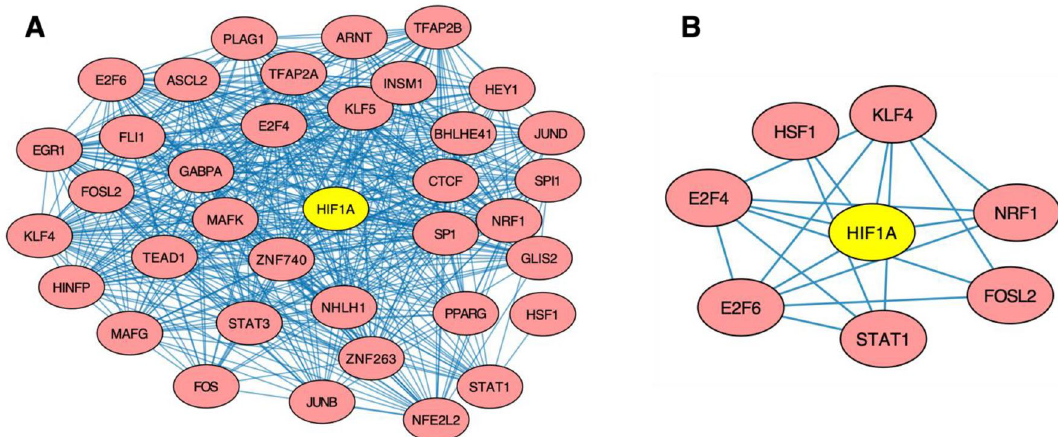
Figure 4. Interactions between discovered HIF1A cofactors. ( A ) Cytoscape representation of the top 37 TFs and their interactions with one another. ( B ) Cytoscape network of interactions between six top novel TF cofactors, HSF1, E2F4, E2F6, STAT1, FOSL2, NRF1, and KLF4. SIOMICS predicted the edges